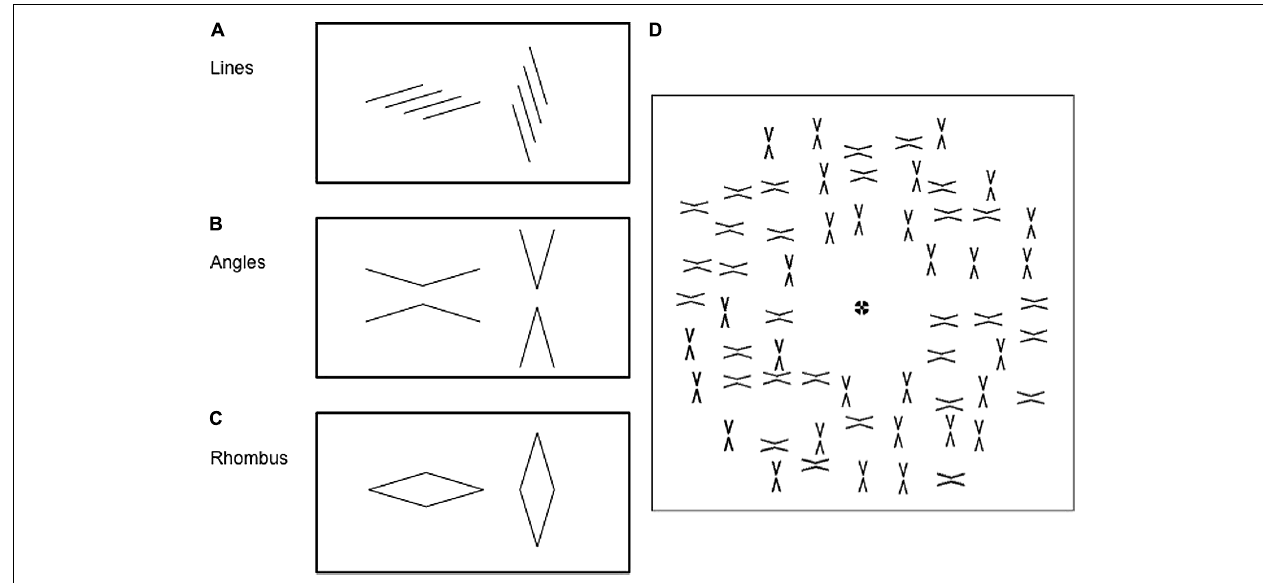
FIGURE 1 | Each of the three types of figures may be presented in 2 configurations: (A) four parallel lines arranged with either a leftward slant or a rightward slant: (B) a pair of obtuse (150 ◦ ) or acute (30 ◦ ) angles; or (C) rhombuses in either a horizontal and vertical configuration.